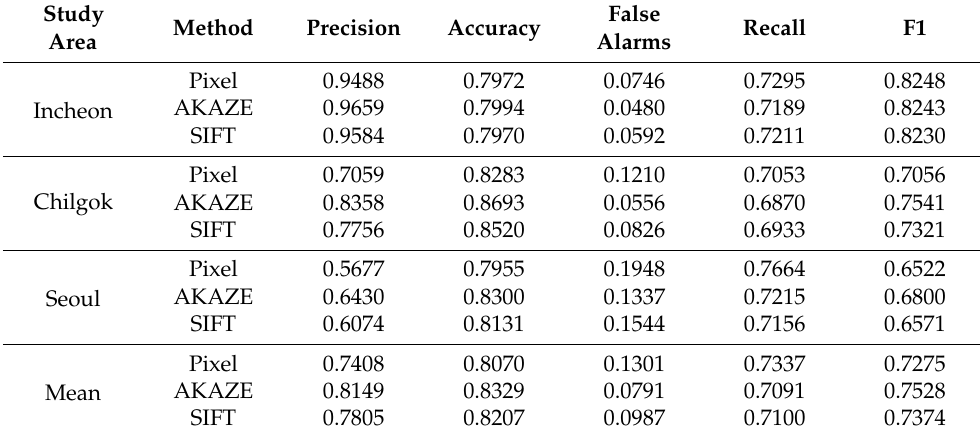
Table 6. Performance of change detection results in the pixel